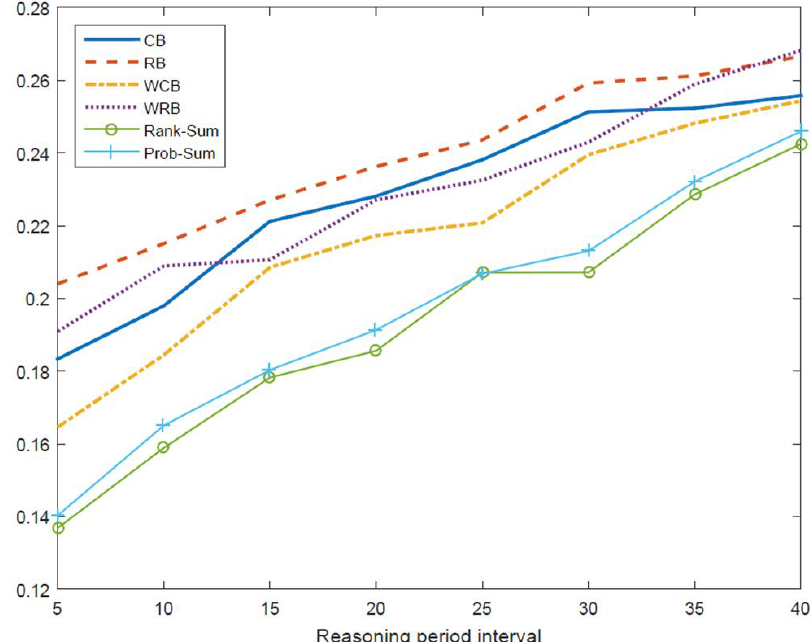
Figure 14. Comparison of collision probability according to reasoning period (number of samples = 20 slots, sample interval = 5